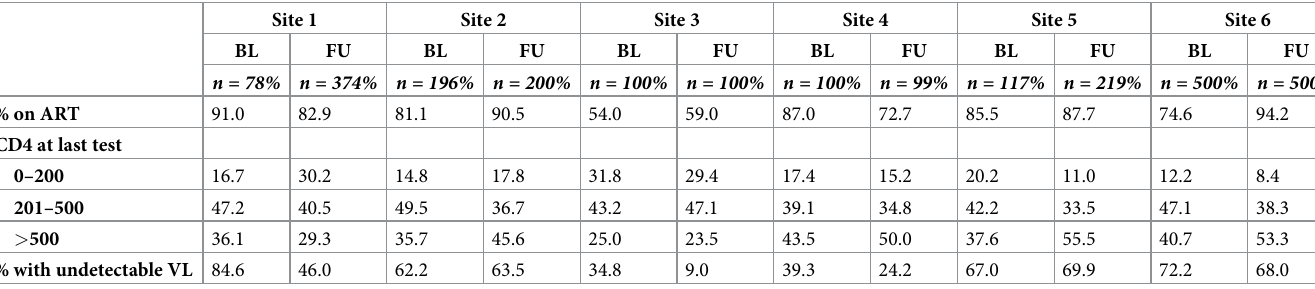
Table 3. Patient ART status, CD4 cell count, and viral suppression at baseline and